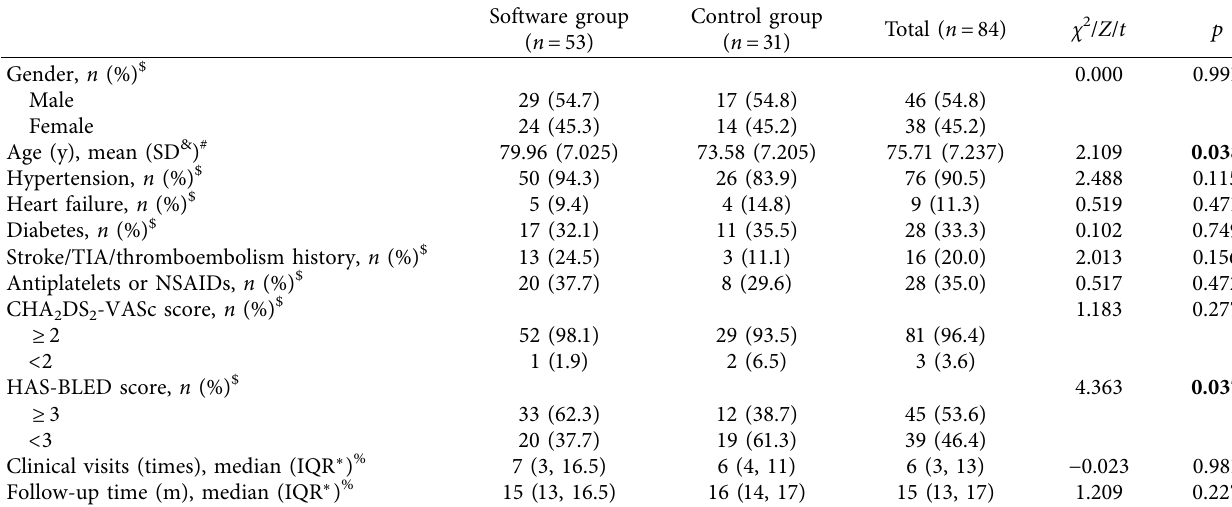
Figure 5: Te study fowchart. Table 1: Basic demographics of the